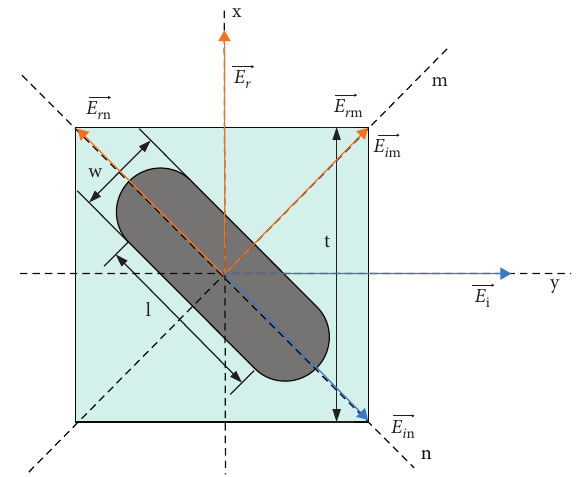
Figure 1: The structure of the capsule-shaped PCM